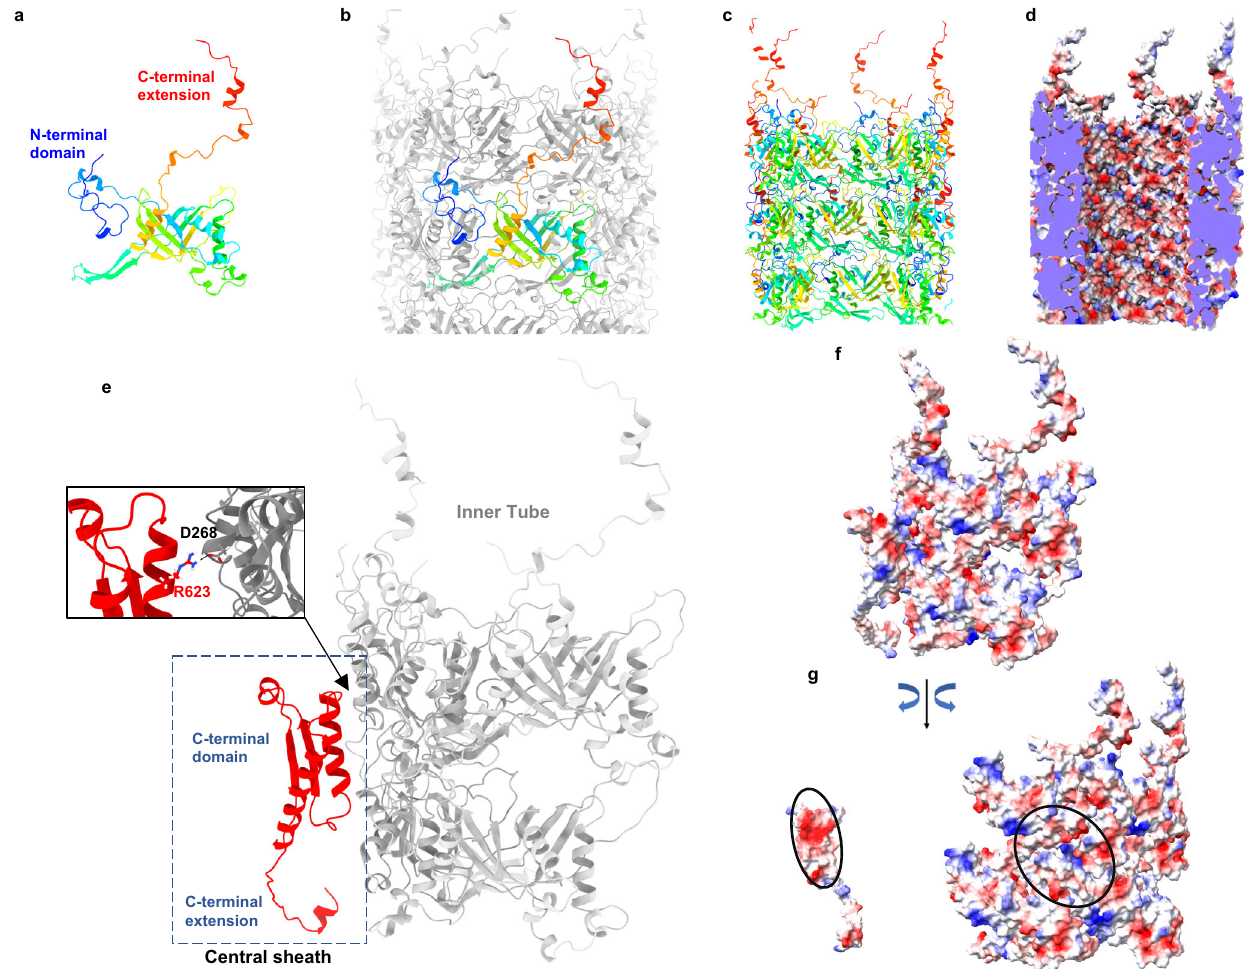
Fig. 4 | Inner tube structure of phage ϕ Kp24 and sheath-tube interaction. a Ribbon diagram of the predicted AlphaFold2 model of ϕ Kp24 ’ s tube-protein monomer gp119, rainbow-colored in ChimeraX. b Ribbon diagram of two discs (hexamers) in the tube of phage ϕ Kp24, one typical gp119 was shown in rainbow color. c Cut-away view as ribbon diagram of the tube structure (three discs). d electrostatic diagrams showing the inner surface of the tube structure in c . Charge distribution: red=negative; blue=positive; white=neutral. Electrostatic